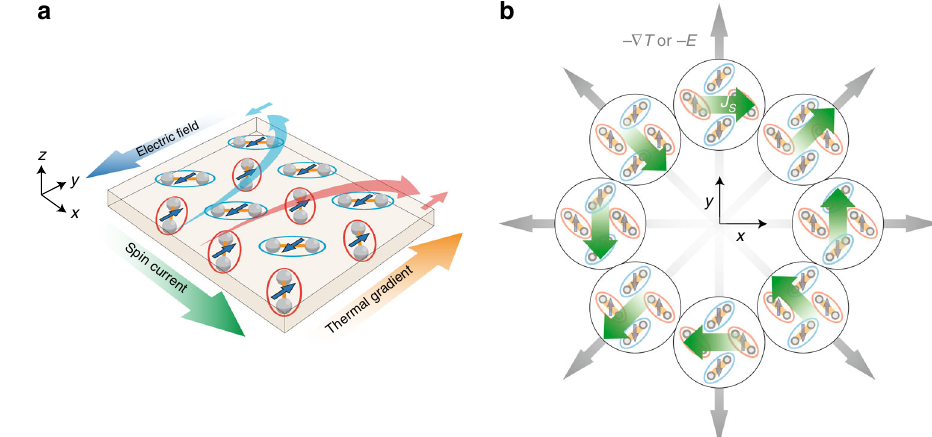
Fig. 1 Schematic illustrations of the spin current generation. a Flows of up- and down-spin magnons (electrons) and spin current driven by a thermal gradient (an electric fi eld) in the AFM state. The red and blue ellipses represent the two kinds of molecular dimers, forming a checker-plate-type lattice. The arrows in the dimers represent the localized spin moments. b Field-angle dependence of the spin current generation (green arrows) driven by a thermal gradient or an electric fi eld (gray